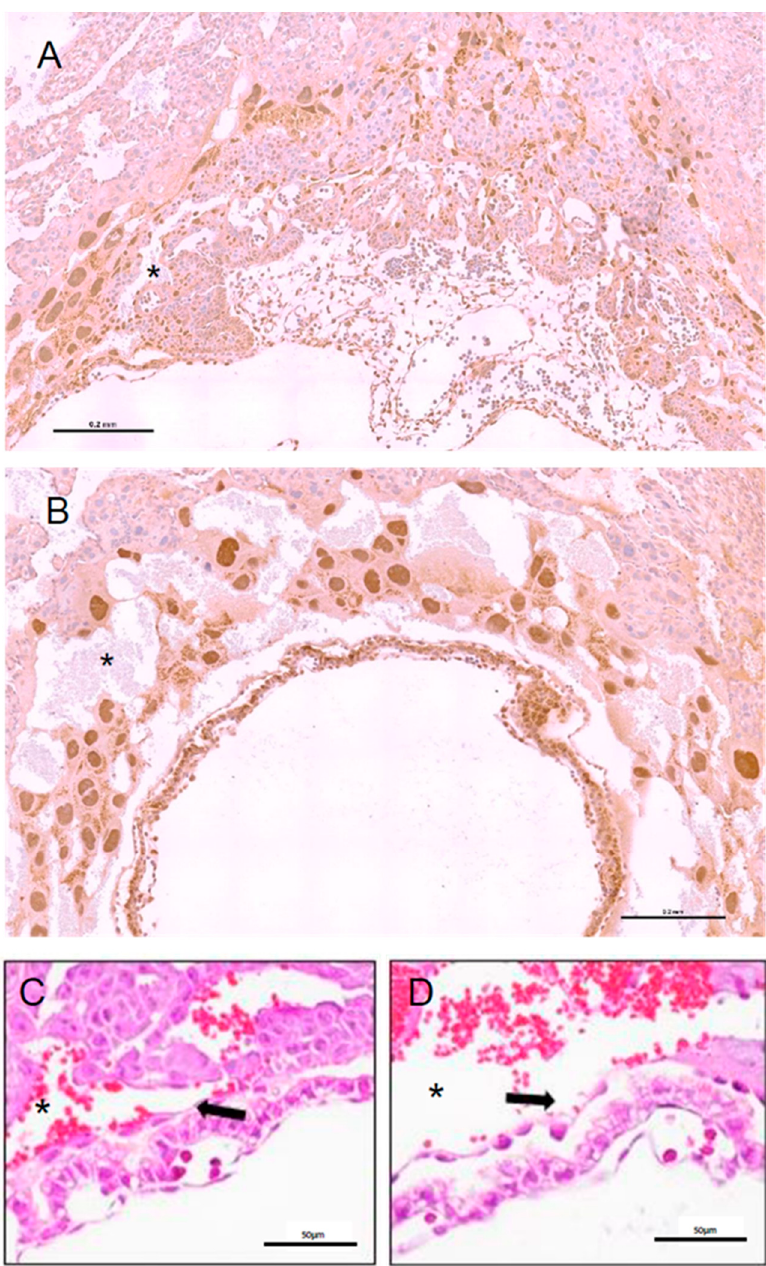
Figure 3. Placenta morphogenesis is impaired as early as embryonic day 9.5 (E9.5) in Nkx2- 5 Cre ;Hand1 A126fs/+ implantations. ( A ) Control littermate placentas ( Nkx2-5 Cre ;Hand1 +/+ ) exhibit invagina- tion of the chorion and development of an early labyrinth at E9.5. ( B ) In contrast, Nkx2- 5 Cre ;Hand1 A126fs/+ placentas lack a chorionic plate and only have a disorganized layer of trophoblast giant cells surrounding the amniotic cavity. ( C ) High magnification of the yolk sac morphology in the normal littermates show adjacent chorion and yolk sac. ( D ) The Nkx2-5 Cre ;Hand1 A126fs/+ placentas lacked a chorionic layer and yolk sacs were detached from the trophoblast layer separated by large maternal blood spaces. Arrows indicate attachment/detachment of the yolk sac. Asterisk indicate maternal blood spaces. ( A , B ) are immunostained for Hand1; scale bar = 0.2 mm. ( C , D ) are stained with hematoxylin and eosin; scale bar = 50 µm.